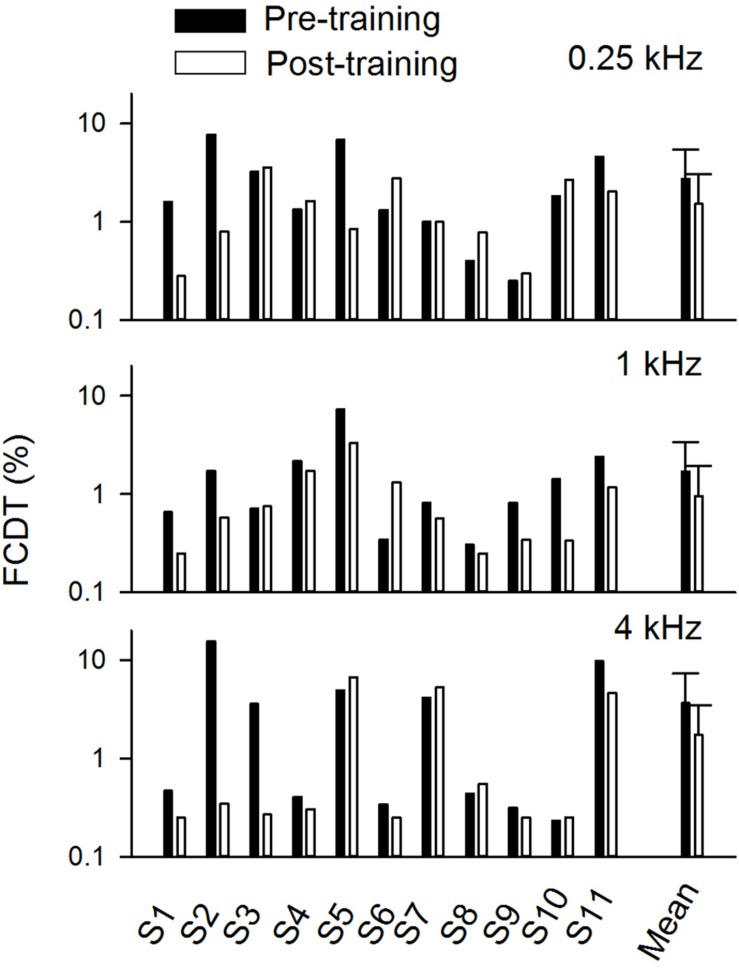
The pre- and post-training FCDTs at different base frequencies in individual subjects and the mean FCDTs of all individuals (n = 11). The error bar indicates 1 standard deviation.